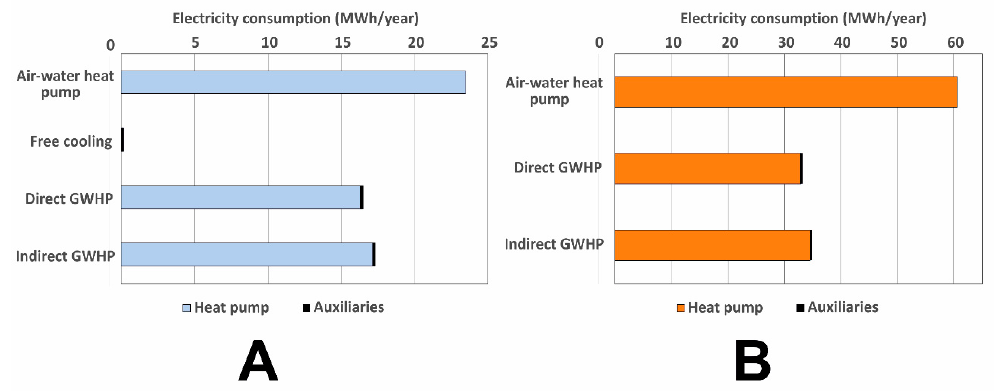
Figure A1. ( A ) Electricity consumption of different cooling options (free cooling, GWHP with direct heat exchange and GWHP with an intermediate heat exchanger), compared to the base case (air–water chiller). ( B ) Electricity consumption of different heating options (GWHP with direct heat exchange and GWHP with an intermediate heat exchanger) compared to an air-water heat pump.